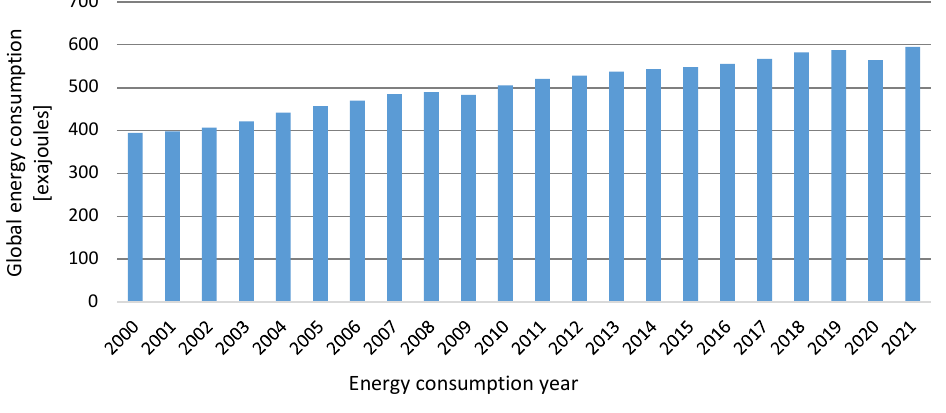
Figure 2. Global primary energy consumption (2000–2021) [25]. Global energy consumption continues to be concentrated around primary energy fuels such as coal and oil. The first place in terms of the largest consumption of primary energy in the world is occupied by China, consuming around 158 EJ in 2021 (Figure 3). The United States is in second place with an average consumption of around 93 EJ. It is followed by India, Russia, Japan, Canada, Germany, and other countries [26]. Renewable energy consumption is projected to increase annually and could reach around 247 EJ by 2050 (Figure 4) [27].